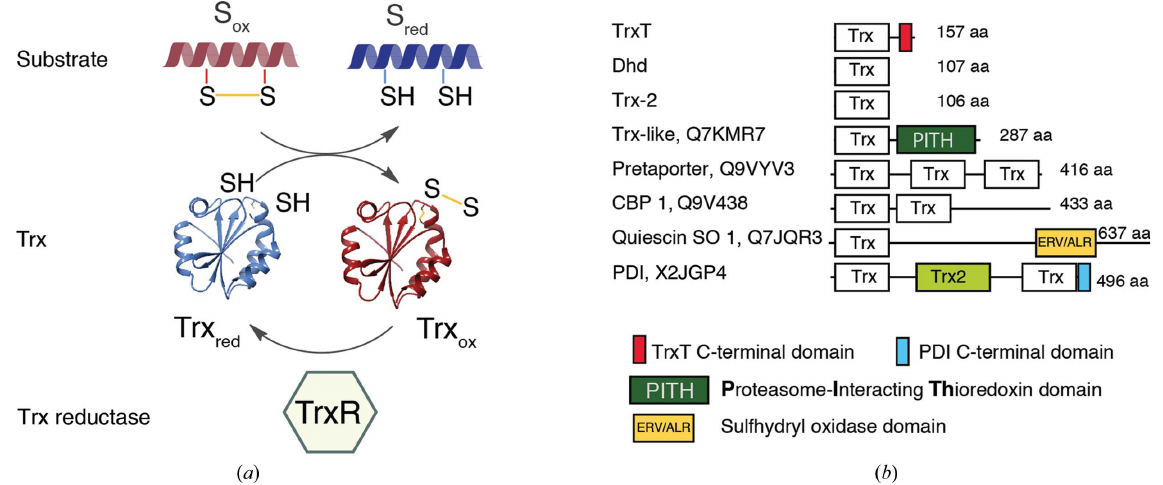
Figure 1 Redox mechanism and Trx proteins in D. melanogaster . ( a ) Schematic description of the Trx–TrxR redox mechanism adapted from Collet & Messens (2010). The redox cycle starts with a reduced form of Trx with the catalytic cysteine (Cys32) in the form of a thiolate [Supplementary Fig. S1( a )]. This state is stabilized by a hydrogen bond to the second cysteine of the motif (the Cys35 SH group). The thiolate is then able to form a transient intermolecular disulfide bond with the cysteine present in the oxidized substrate. The catalytic cycle ends when Cys35 in the enzyme attacks this intermolecular disulfide and forms a new intramolecular bond with Cys32, releasing the reduced substrate and the oxidized enzyme (Fomenko et al. , 2008). Trx recovers its initial state by the action of the Trx reductase (TrxR), which reduces Trx using NADPH/FAD as a source of reducing equivalents. ( b ) Trx-containing proteins in D. melanogaster . UniProt codes and domains are indicated. Abbreviations: CBP, calcium-binding protein; PDI, protein disulfide isomerase; SO, sulfhydryl oxidase. The ioelectric points for the different Trx domains are as follows: 6.5 for Q7KMR7, 5.0 for Q9VYV3 (three domains), 6.6 for Q9V438 (two domains), 4.9 for Q7JQR3 and 5.1 for X2JGP4 (two domains). A sequence alignment of these domains is shown in Supplementary Fig. S1( b